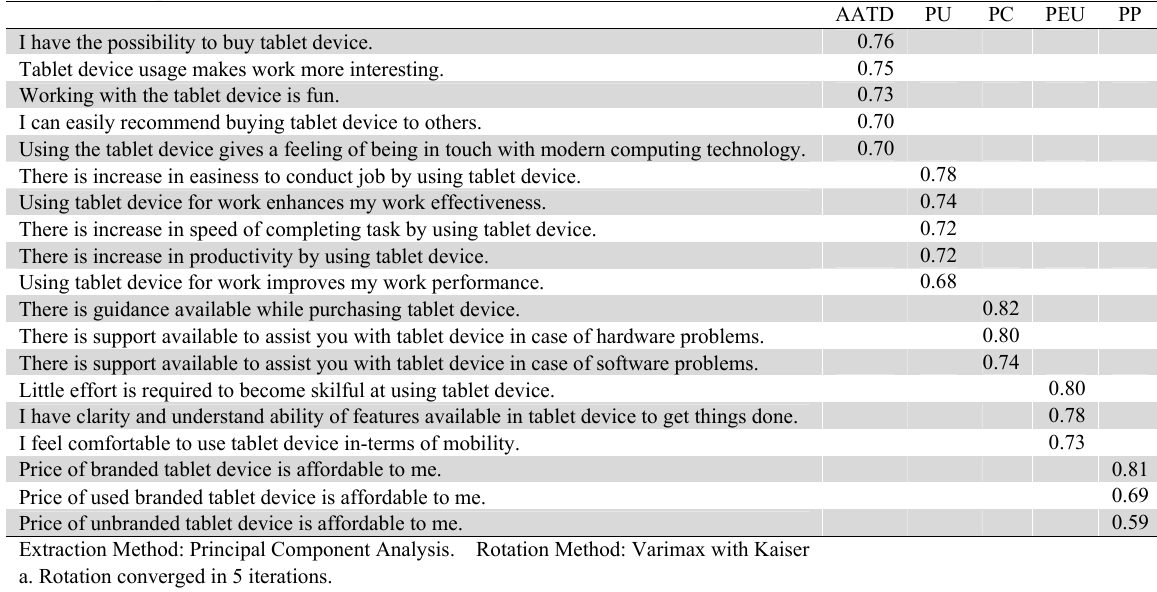
Rotated Component